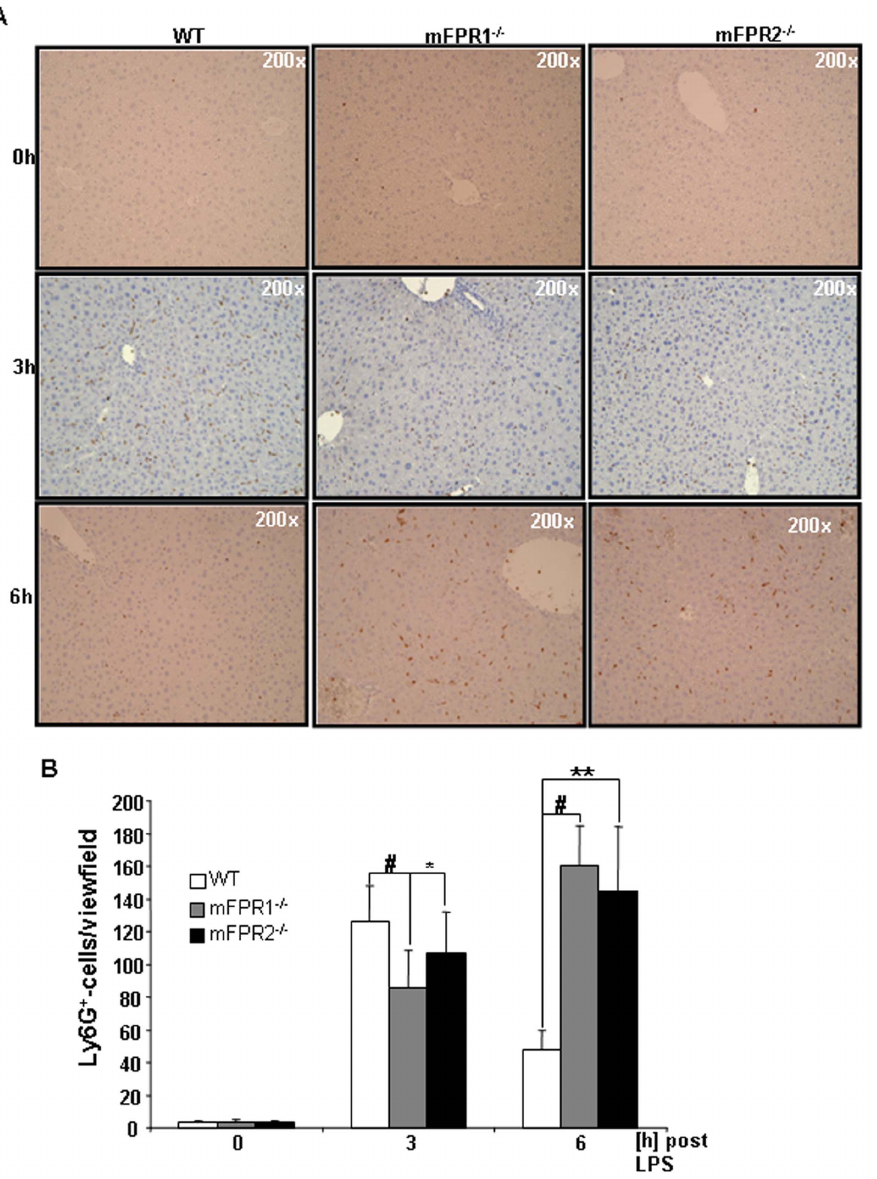
Figure 3. The second subset of immune cells were analysed by Ly6G-staining. Mainly neutrophil granulocytes were identified as Ly6G + (A). Pictures were taken in 200-fold magnification and the Ly6G + -cells were counted. The results were displayed as a graph (B) indicating differences among WT, mFPR1 -/- and mFPR2 -/- (*=p , 0.05; **=p , 0.01; # =p , 0.0001).